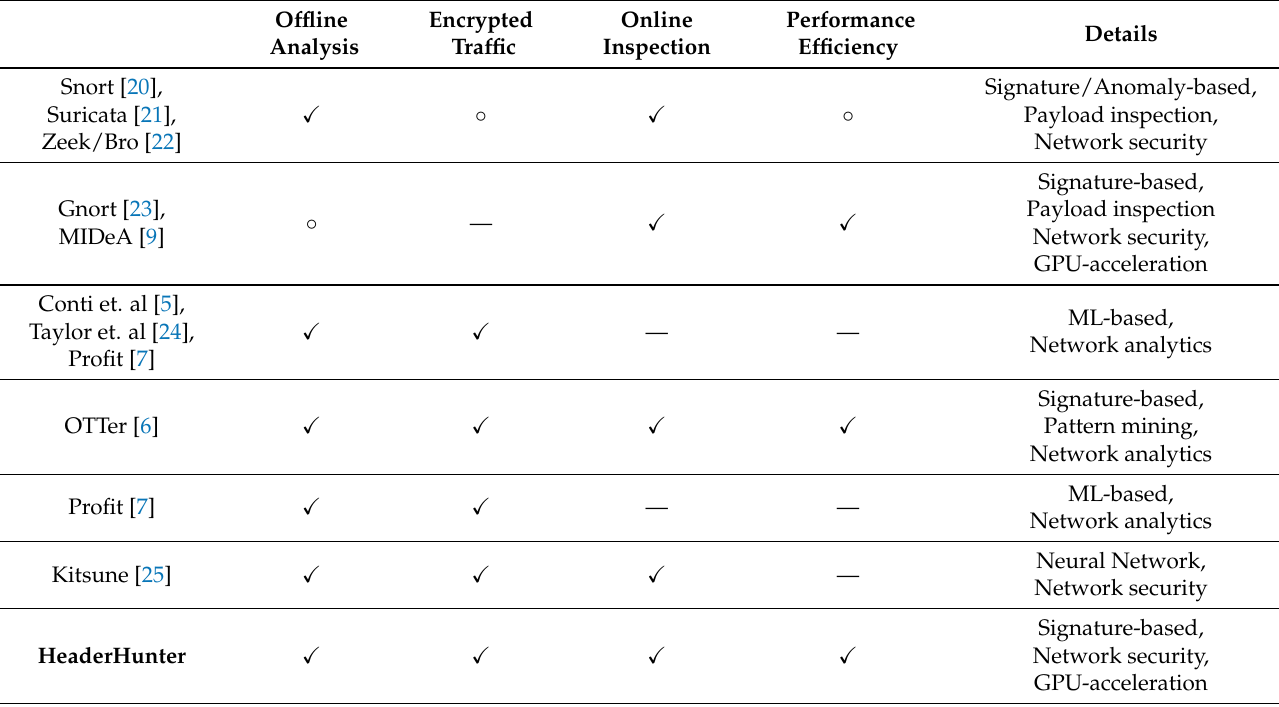
Table 10. Comparison of recent network traffic inspection and intrusion detection